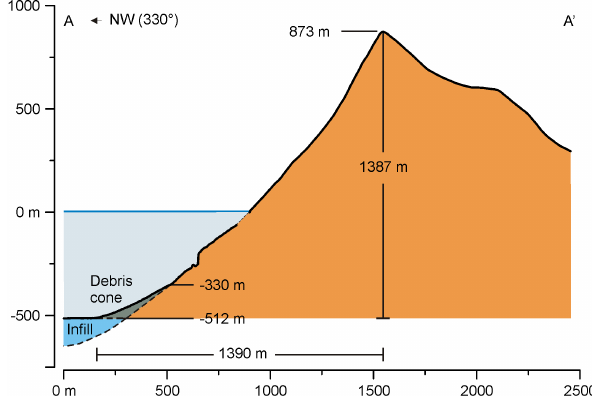
Figure 6. Profile of the rock slope at Adeane Point, including a schematic representation of submarine debris cone and fjord infill